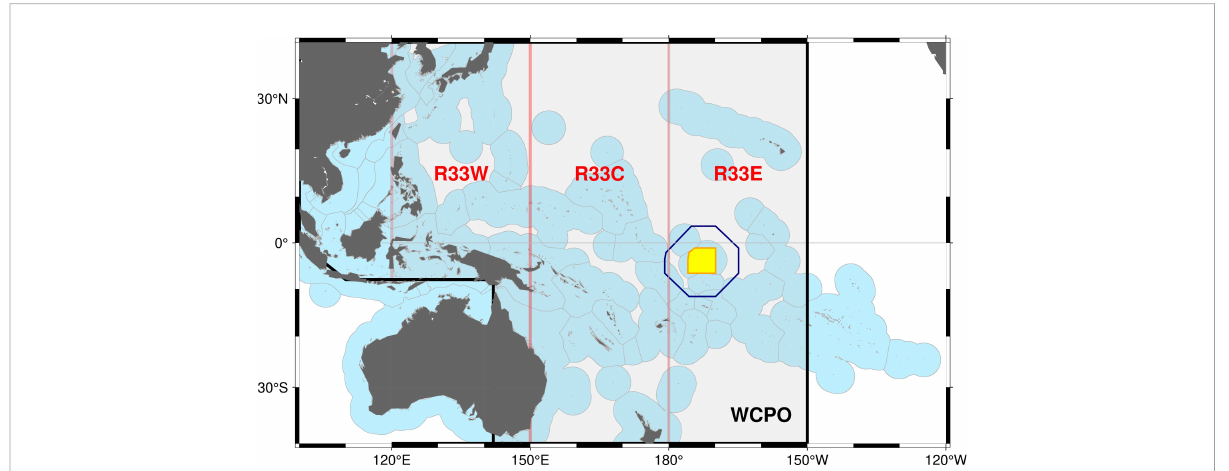
FIGURE 1 The western and central Paci fi c Ocean showing the Exclusive Economic Zones of coastal States (light blue), PIPA (yellow), the fi ve-degree spill- over area (blue line) and the western (R33W), central (R33C) and eastern (R33E) zones of the western and central Paci fi c Ocean (WCPO, delineated by the thick black line) evaluated as hypothetical large oceanic Marine Protected Areas.